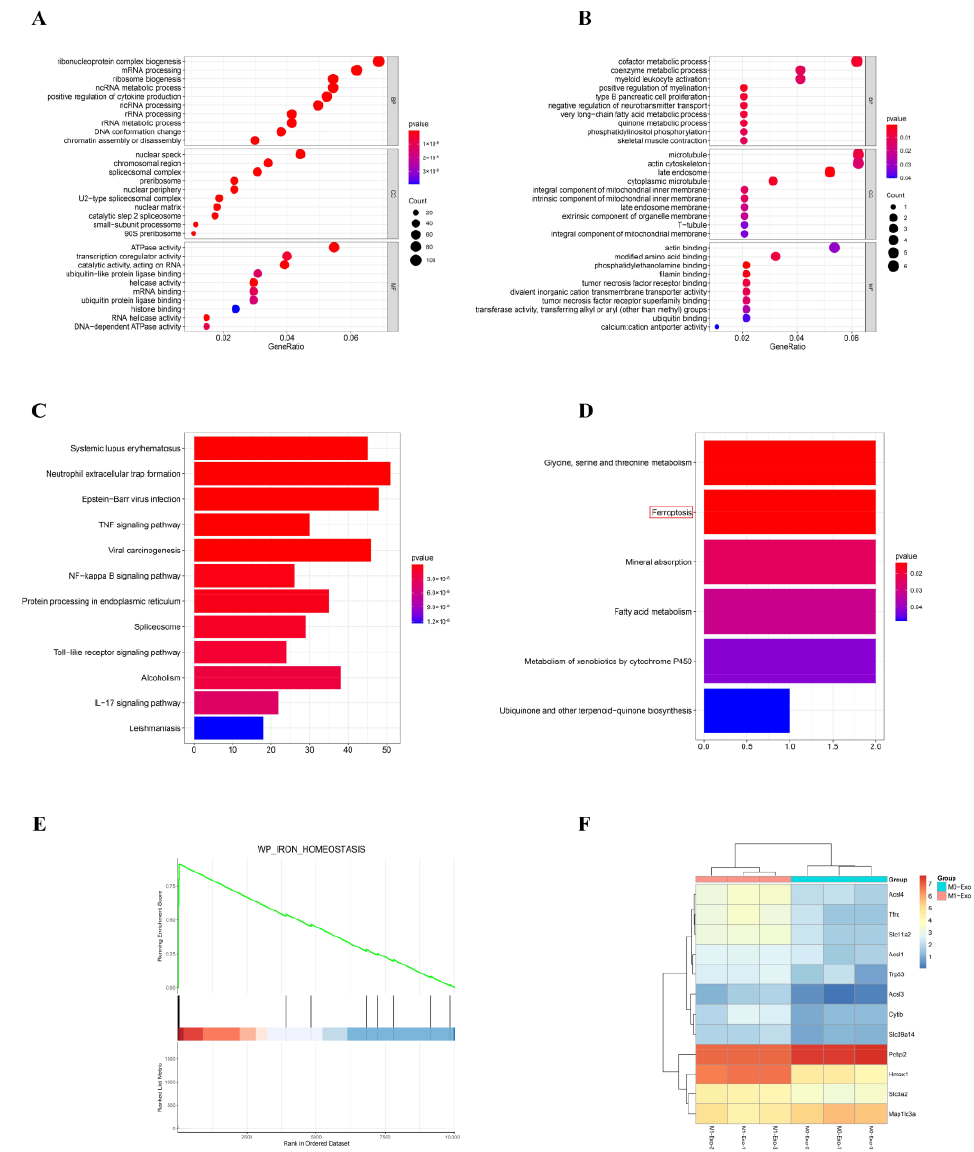
Figure 3. Results of the GO, KEGG, and GSEA enrichment analyses. ( A , B ) The top 10 enriched GO items (BP, CC, and MF) of upregulated and downregulated DEGs. ( C ) The top 10 pathways identified in which upregulated DEGs were enriched. ( D ) The ferroptosis pathway was prominently enriched (red mark). ( E ) Iron homeostasis was enriched in GSEA results. ( F ) A comparison of DEG expressions in ferroptosis pathway.